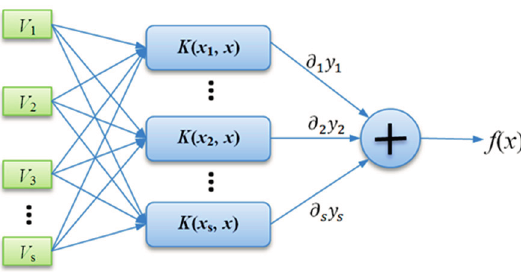
Figure 13. Flow-chart of the hybrid